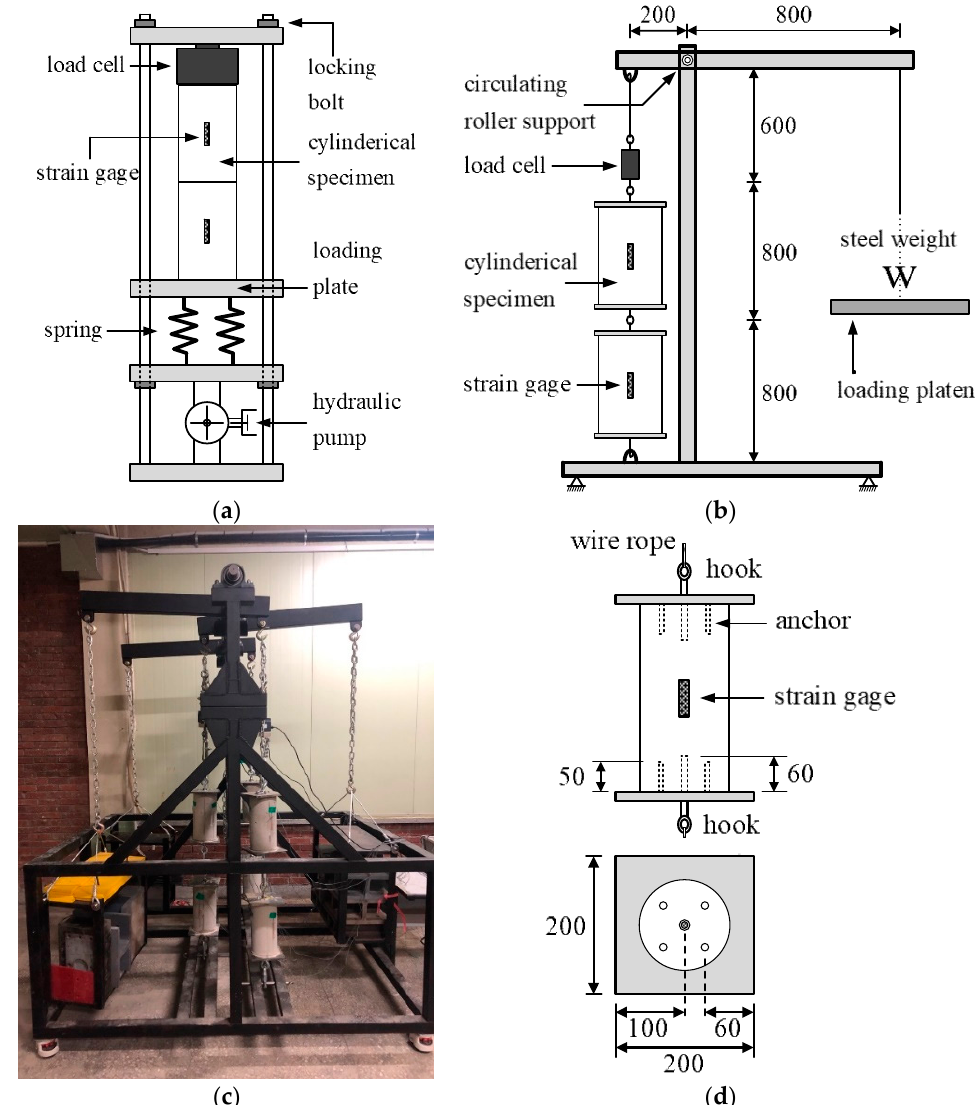
Figure 1. Creep test apparatus and specimen: ( a ) compressive creep testing apparatus, ( b ) tensile creep test specimen, ( c ) testing device with three sets of loading systems, and ( d ) schematic drawing of serially connected loading system (unit: mm).